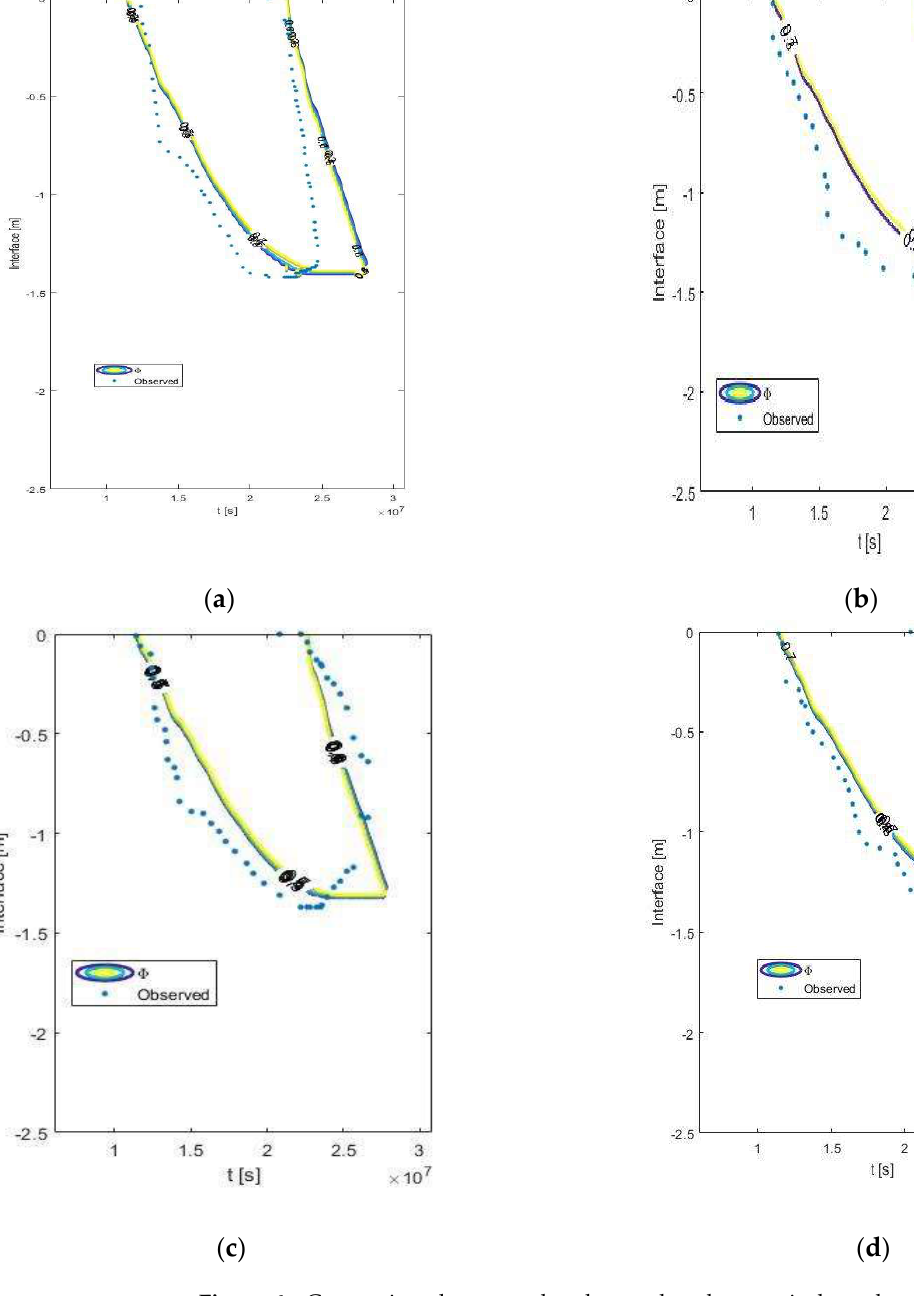
Figure 6. Comparison between the observed and numerical results of the thaw depth in 1962, ( a ) Site 2 (Rocky talus), ( b ) Site 11 (mountain tundra), ( c ) Site# 15 Sparse growth of forest, ( d ) Site #17 (Larsh forest). Table 6. Numerical errors of the simulated thaw